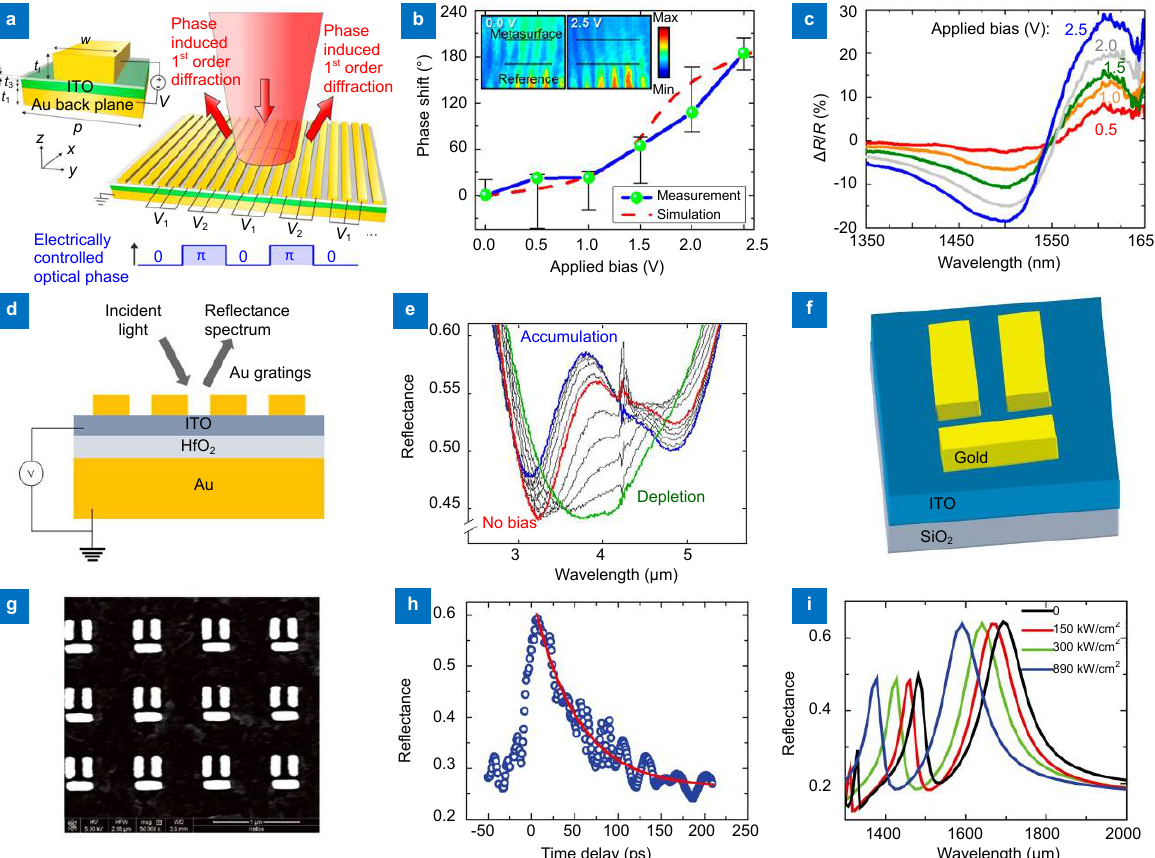
Fig. 5 | Tunable metasurfaces using ITO as an active layer. ( a ) Schematic of the tunable metasurface which consists of a quartz substrate, gold backplane, and a thin ITO film followed by a thin alumina film on which gold stripe nanoantenna array is patterned on. ( b ) Measured relative reflectance change from the metasurface for different applied voltages. ( c ) Measured and simulated phase shift as a function of applied bias for the applied voltage. The black lines show the cross-section for analyzing the phase. ( d ) Device schematic showing an electrically-tunable ITO film clamped between an HfO 2 -coated Au substrate and an array of Au strips. With positive and negative electric biases, the carrier concentration of ITO can be decreased (depletion) or increased (accumulation), leading to changes in the optical properties of the ITO. ( e ) Reflectance spectra were taken from the device measured using an FT-IR microscope. The red, blue, and green curves denote the reflectance spectra under 0 V for no bias, − 5 V for accumulation, and +5 V for depletion, respectively. The grey curves represent reflectance spectra for intermediate voltages with an incremental step size of 1 V. ( f ) Schematic structure of the meta-molecule and ( g ) top-view small-scale SEM image of the metamaterial. ( h ) Measured reflectance changes of a 1550 nm probe laser as a function of delay time between pump and probe pulses. The red solid line is the exponential fit to the data. ( i ) The calculated reflectance spectrum of the metamaterial with different pump intensity by the finite element method. Figure reproduced from: ( a – c ) ref. 47 , American Chemical Society; ( d , e ) ref. 85 , Creative Commons Attribution 4.0 International License; ( f – i ) ref. 59